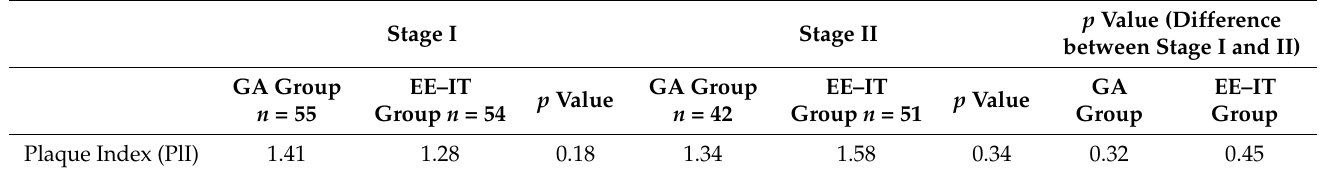
Table 2. Mean values of the Plaque Index (PlI) in the GA and EE–IT students in the first and second stages of the study.